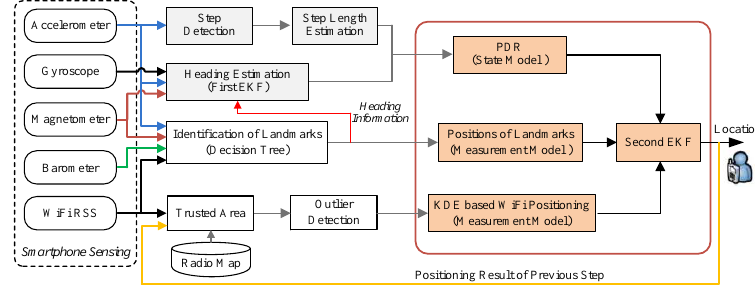
Figure 1. Overview of the proposed extended Kalman filter (EKF)-based fusion approach.